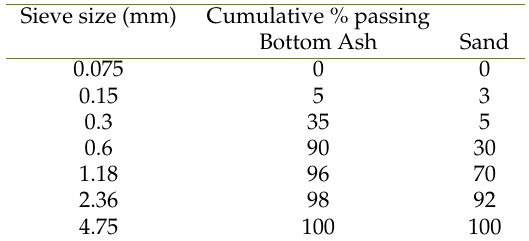
Table 4. Particle dimensions dispersal of sand and bottom